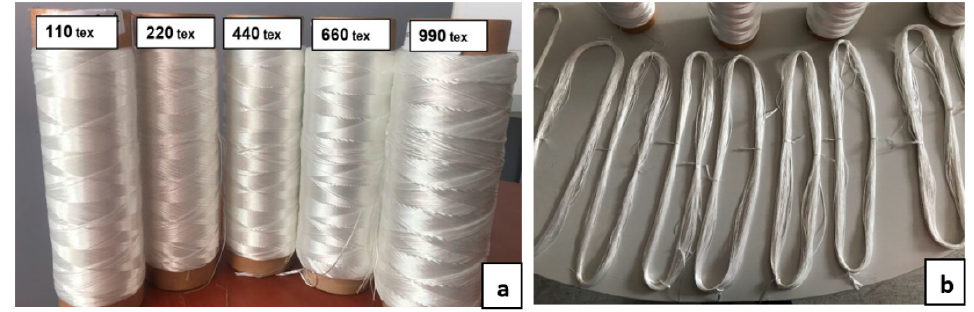
Figure 1. ( a ) Yarn samples in bobbin form; ( b ) Yarn samples in hank form.